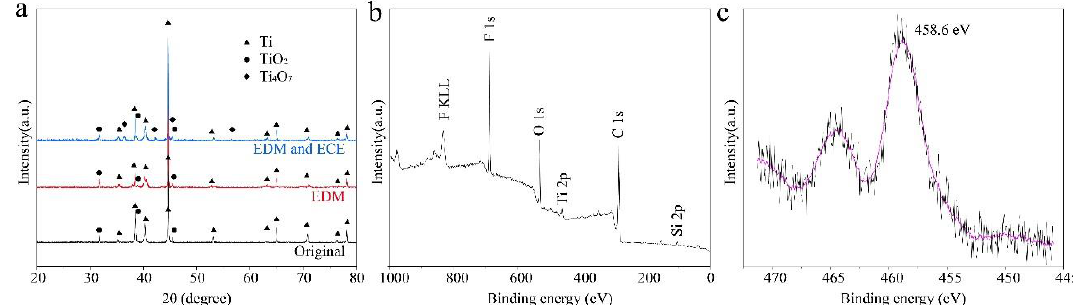
Figure 8. Characterization of the chemical structure of surfaces under different processes. ( a ) XRD pattern of the original titanium surface, EDM surface, and EDM and ECE process, ( b ) XPS of the survey spectrum of the as-prepared superhydrophobic surface, ( c ) high-resolution XPS scanning of the Ti 2p spectrum of the as-prepared superhydrophobic surface.